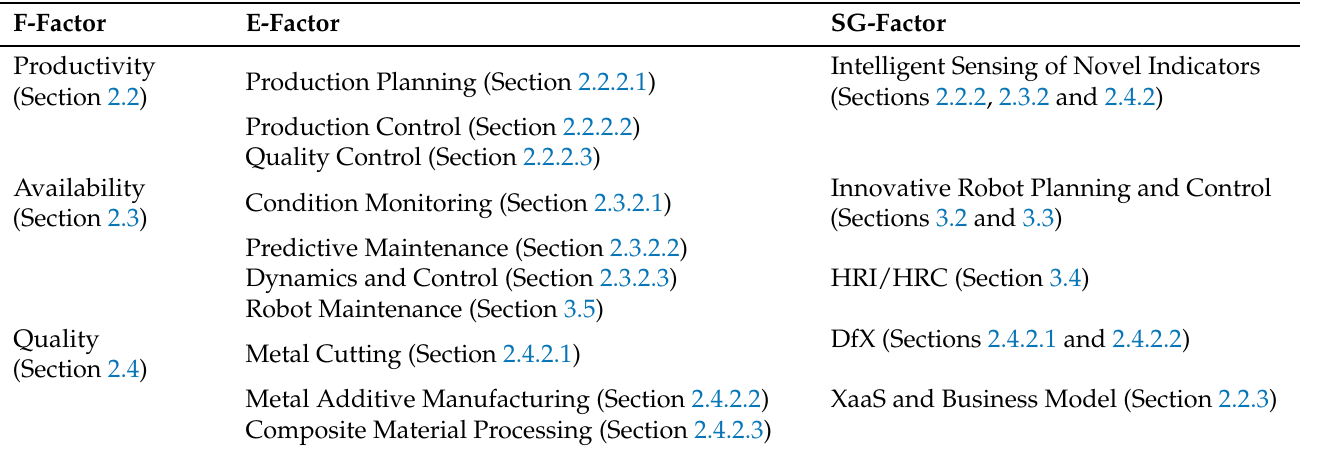
Table 5. Summary of AI-enabled DTs in sustainable development and FESG